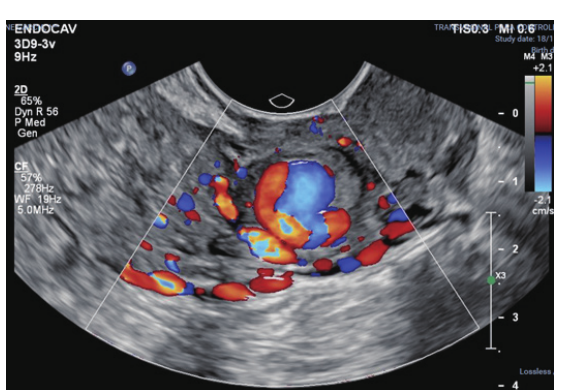
Figure 3 Color Doppler ultrasound demonstrating a vascular structure in the uterus with typical “ying-yang” signal, which characterizes the bidirectional flow, compatible with a right uterine artery